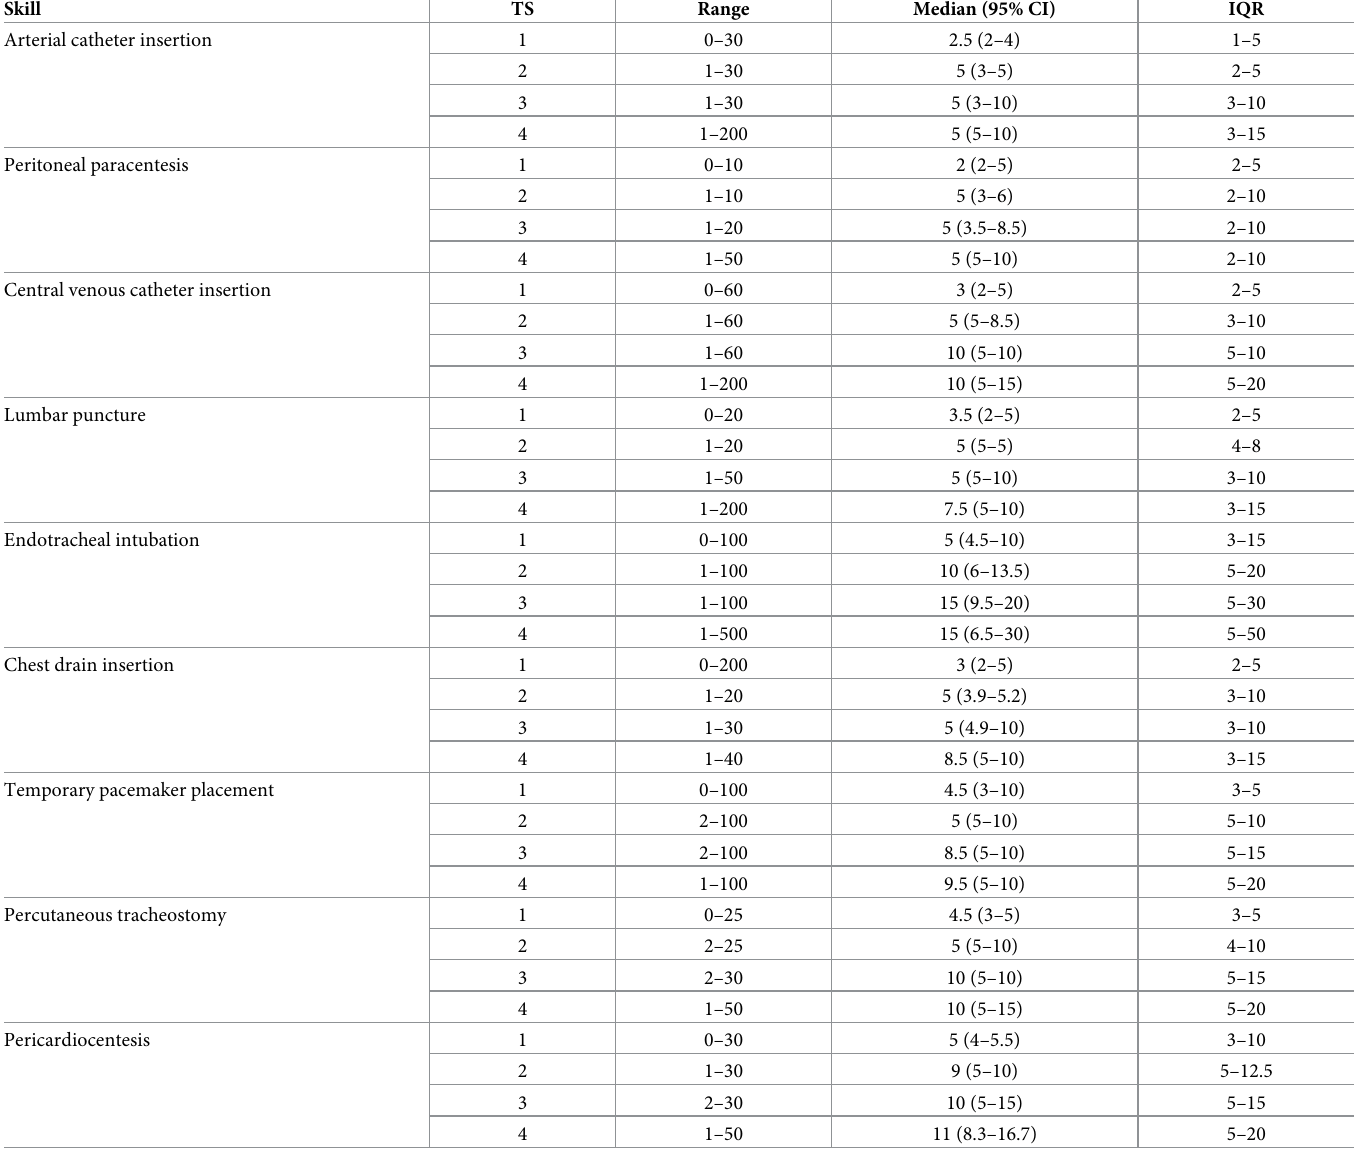
Table 6. Number of skill repetitions required to move to next perceived teaching